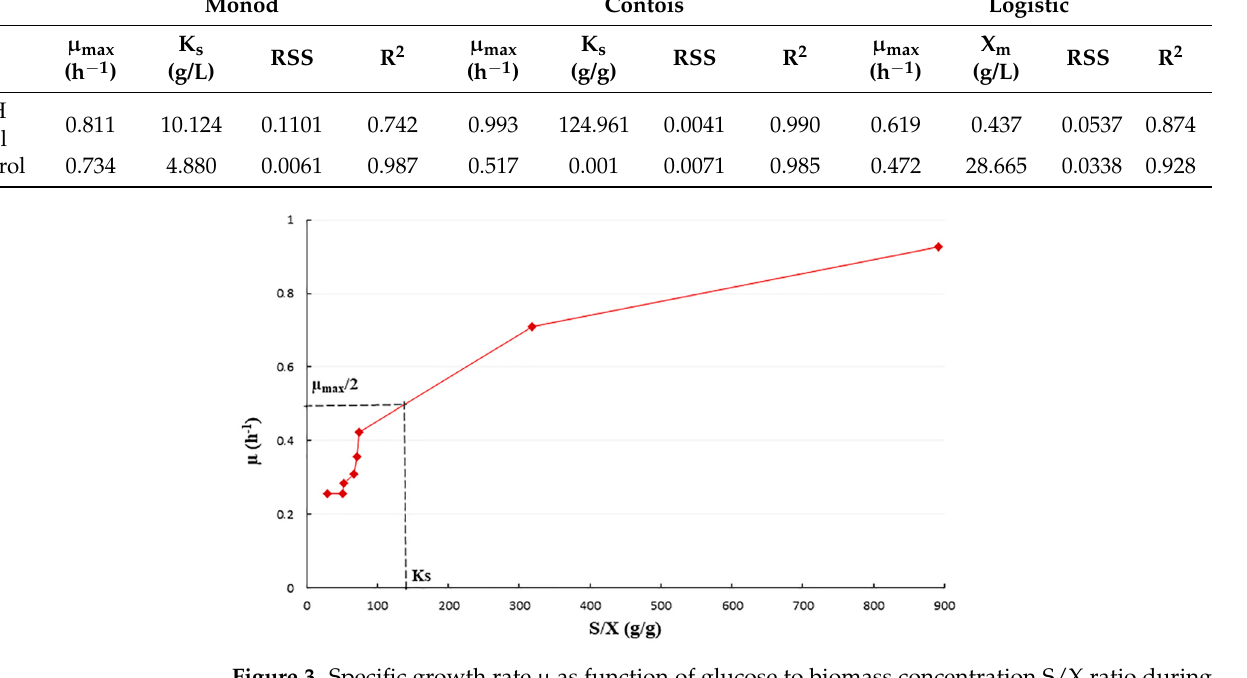
Figure 3. Specific growth rate µ as function of glucose to biomass concentration S/X ratio during fermentation without pH control. Dashed lines indicate the values calculated for µ max and Ks by the Contois model.